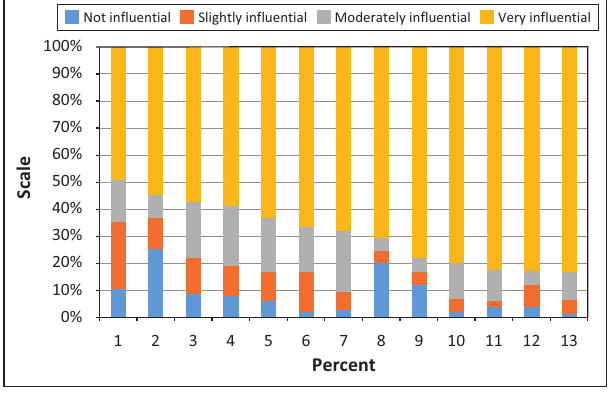
FIGURE 7: User satisfaction with tuk-tuk service.